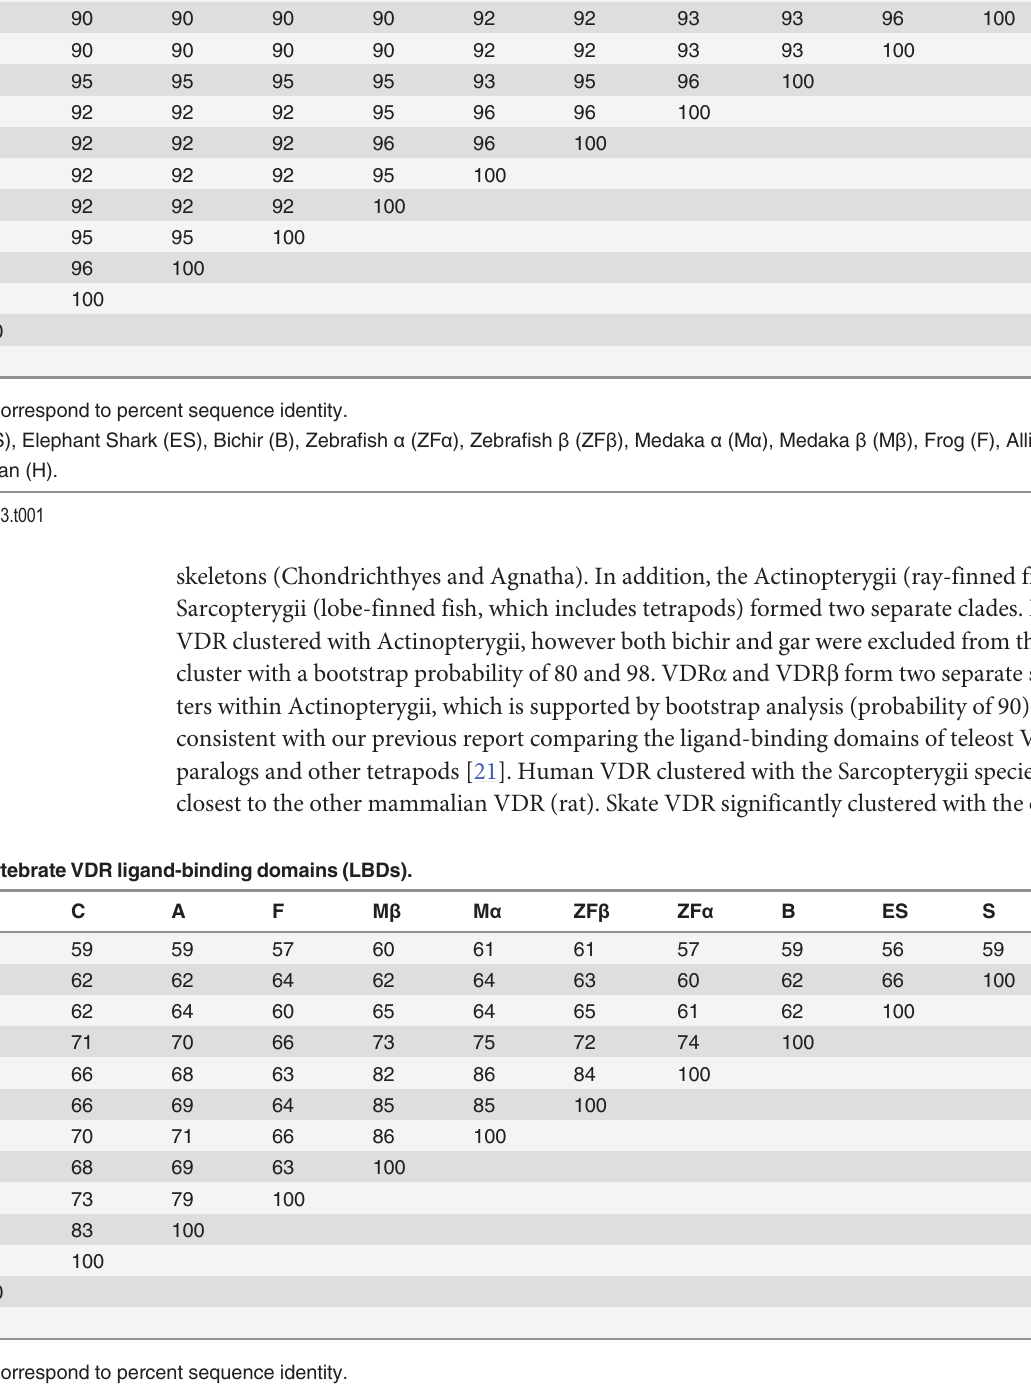
Table 1. Homology of vertebrate VDR DNA-binding domains (DBDs). H